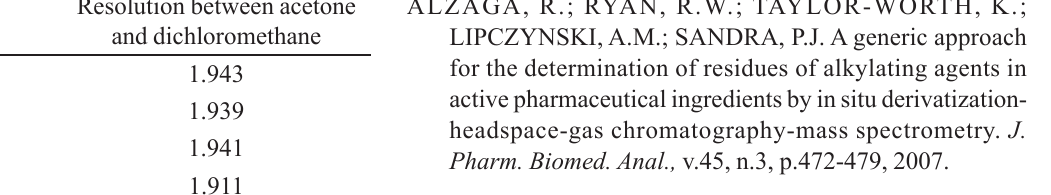
TABLE VI - System suitability Experiment Resolution between